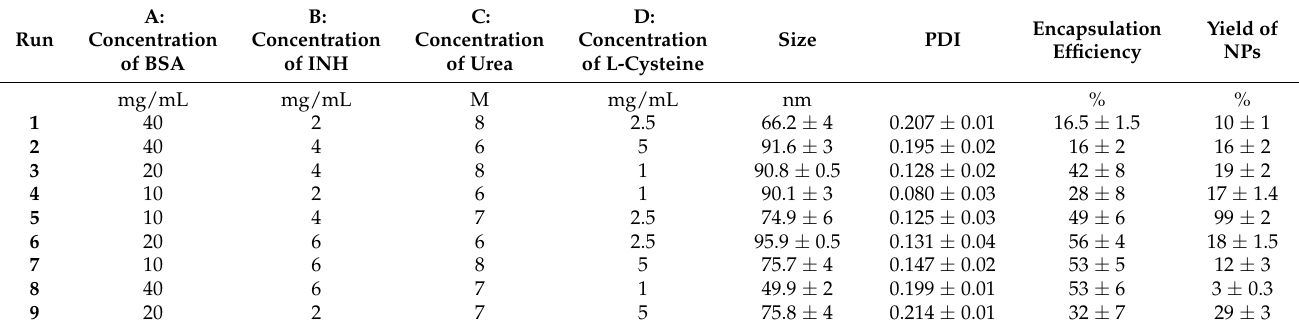
Table 2. Particle size and polydispersity index (PDI) of the BSA-INH NPs obtained.